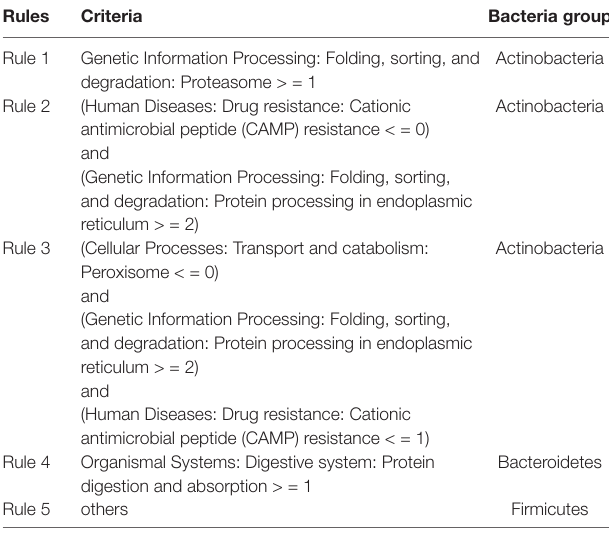
TABle 1 | Five classification rules produced by the RIPPER algorithm for Actinobacteria, Bacteroidetes, and Firmicutes. Rules